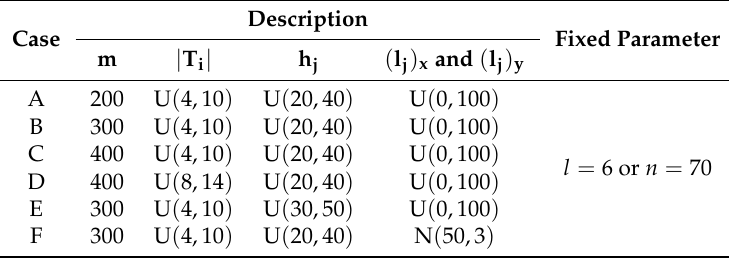
Table 2. The description of different cases.